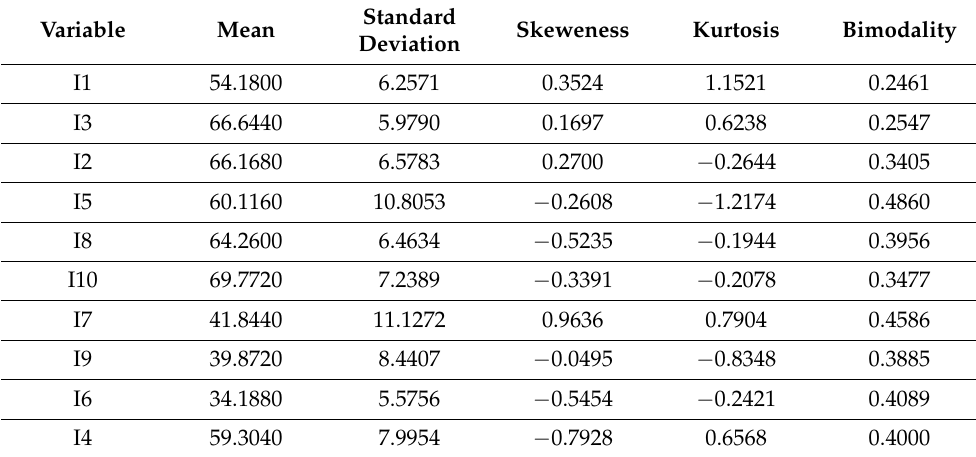
Table 3. Descriptive statistics for the main research